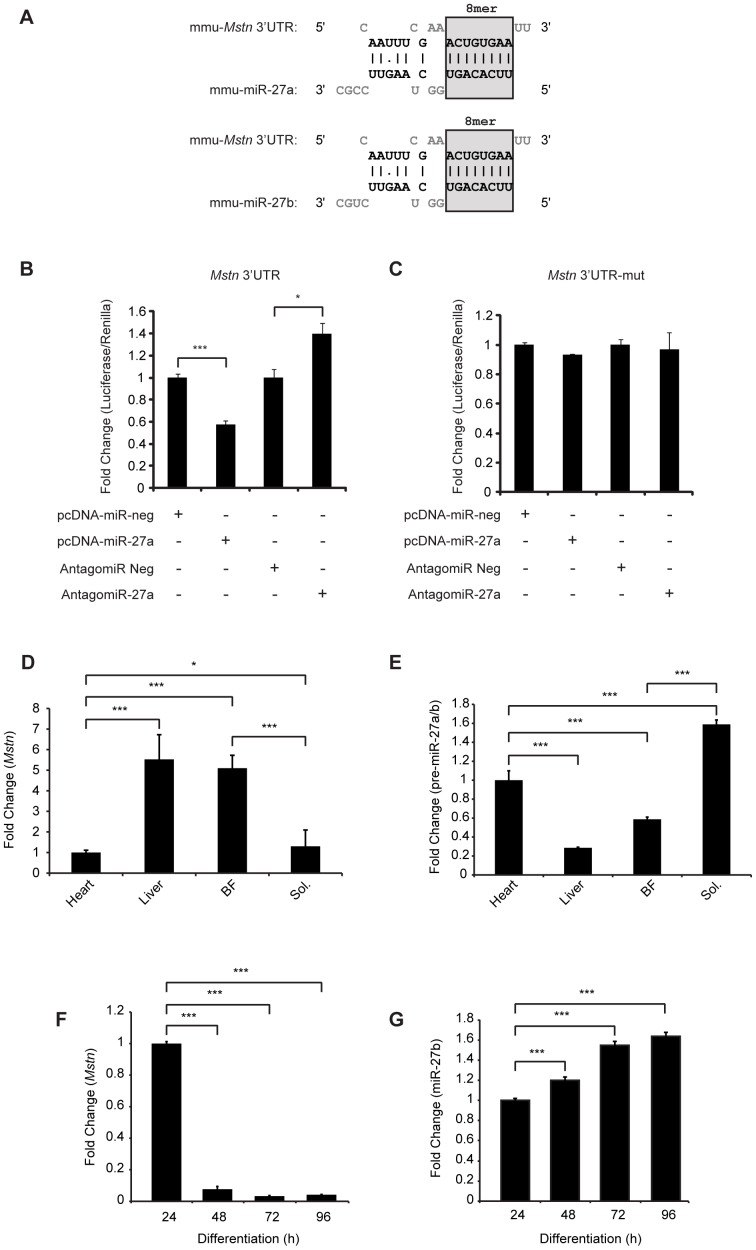
miR-27a/b targets and represses Mstn expression.(A) In silico analysis, using TargetScan algorithms, showing a 8 mer seed match (grey box) between murine miR-27a (mmu-miR-27a) and miR-27b (mmu-miR-27b) and the miR-27a/b binding site located within the Mstn 3′ UTR sequence (mmu-Mstn 3′UTR). (B) Assessment of pMIR-REPORT™ luciferase activity in C2C12 myoblasts co-transfected with the Mstn 3′UTR reporter construct (Mstn 3′UTR) and either control (pcDNA-miR-neg), miR-27a over expression construct (pcDNA-miR-27a), negative control AntagomiR (AntagomiR Neg) or a miR-27a-specific AntagomiR (AntagomiR-27a) for 48h. (C) Assessment of pMIR-REPORT™ luciferase activity in C2C12 myoblasts co-transfected with the mutant Mstn 3′UTR reporter construct (Mstn 3′UTR-mut), where the miR-27a/b binding site has been mutated, and either control (pcDNA-miR-neg), miR-27a over expression construct (pcDNA-miR-27a), negative control AntagomiR (AntagomiR Neg) or a miR-27a-specific AntagomiR (AntagomiR-27a) for 48h. For all pMIR-REPORT™ transfections, luciferase activity was normalized to Renilla luciferase and expressed as fold change relative to control (pcDNA-miR-neg). Bars represent mean values ± S.E.M (n = 3). p<0.05 (*) and p<0.001(***). qPCR analysis of Mstn mRNA expression (D) and precursor-miR-27a/b (pre-miR-27a/b) expression (E) in Heart, Liver, M. Biceps femoris muscle (BF) and M. Soleus muscle (Sol.) collected from 4-week-old wild type (WT) mice. Bars represent fold change (relative to Heart) ± S.E.M (n = 3) normalized to GAPDH (D) or U6 (E) expression. p<0.05 (*) and p<0.001(***). qPCR analysis of (F) Mstn and (G) miR-27b expression in C2C12 myoblast cultures differentiated across a time course (24 h, 48 h, 72 h and 96 h differentiation). Bars represent fold change (relative to 24 h control) ± S.E.M (n = 3) normalized to either GAPDH (F) or U6 (G) expression. p<0.001(***).